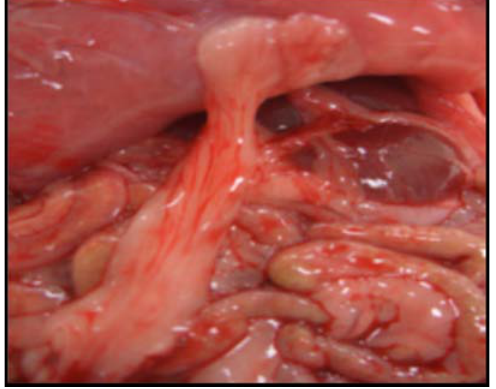
FIGURE 12 - Epiplon adherence to the mesh. Polypropylene